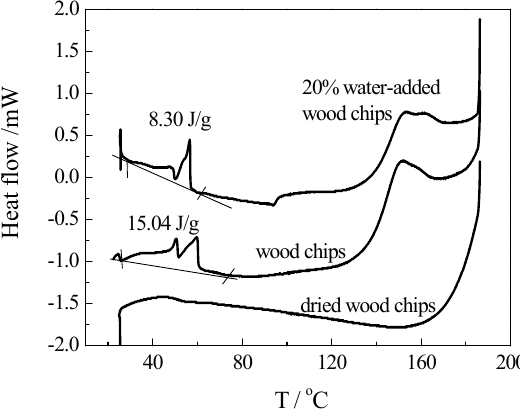
Figure 3. MS80 results of wood chips (sample: 1.4 g, heating rate: 0.02 K/min).